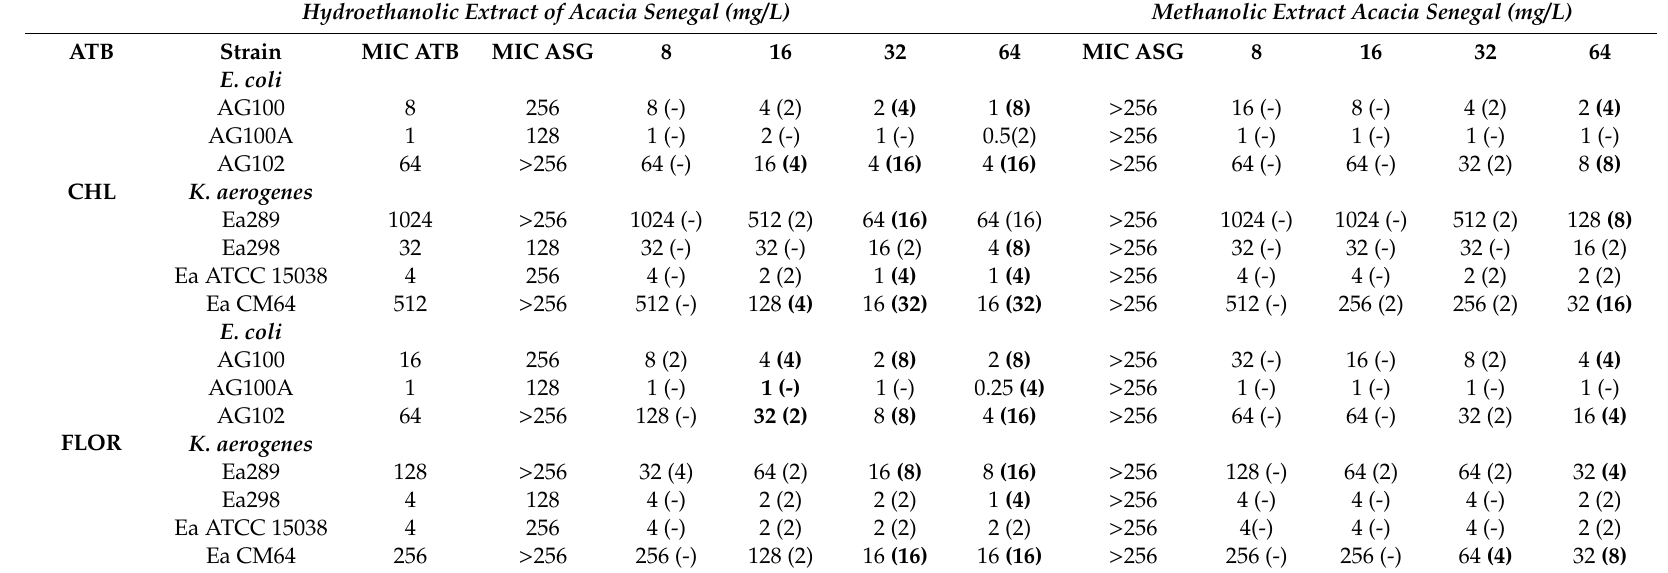
Table 6. Adjuvant activity of leaves extract of A. senegal, MIC in mg / L (Gain). Bacteria strains, MIC (mg / L) of antibiotics in the presence and absence of the extract. Hydroethanolic Extract of Acacia Senegal (mg / L) Methanolic Extract Acacia Senegal (mg / L) ATB Strain